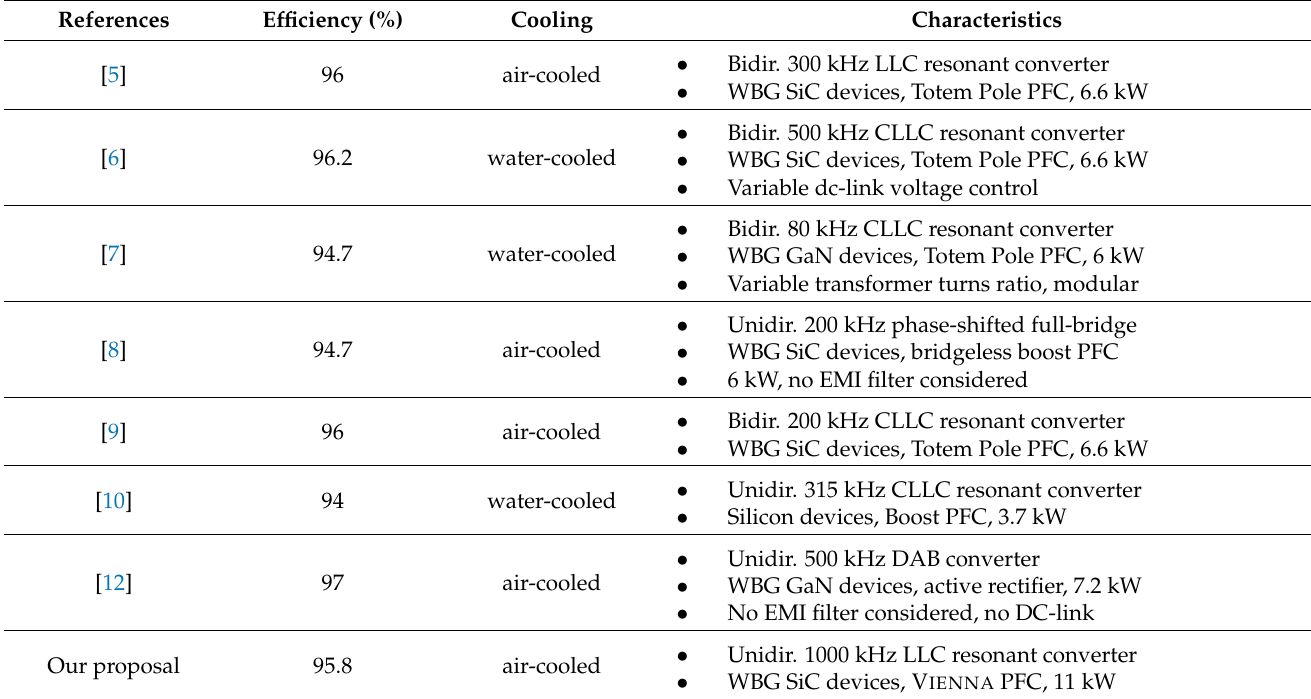
Table 9. Comparison between the proposed portable off-board charger and other state-of-the-art galvanically isolated on-board